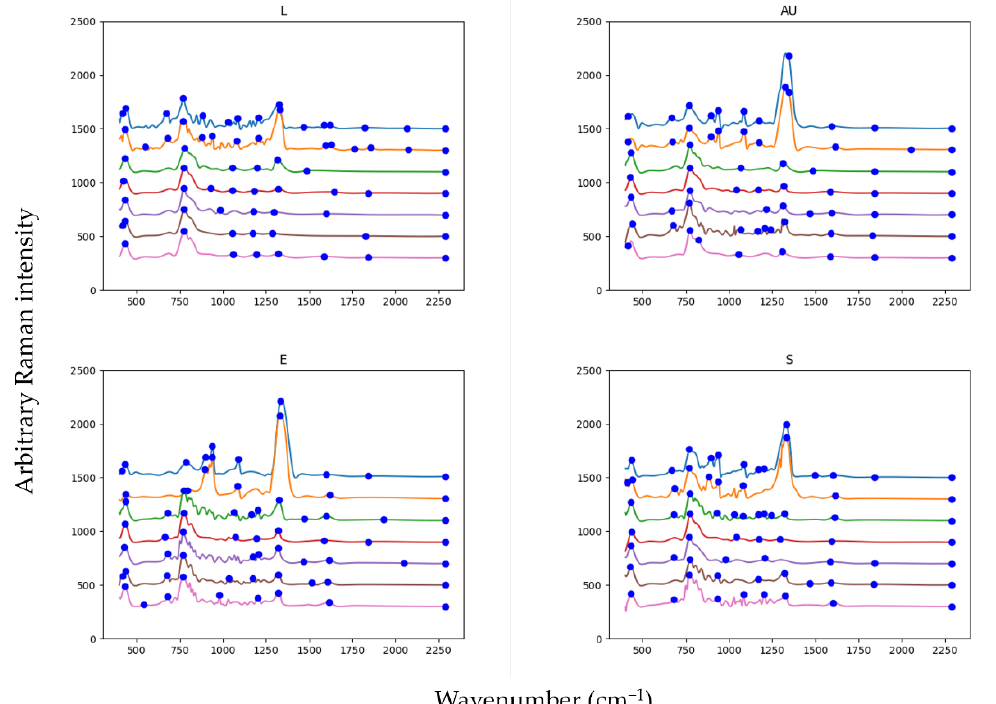
Figure 1. Raman spectra for each monoculture: L. monocytogenes (L), S. aureus (AU), E. coli (E), and S. enterica (S); lines are displayed for better observation and represent the spectra acquired at different time points from top to bottom: 24 (blue), 18 (orange), 8 (green), 6 (red), 4 (purple), 2 (brown), and 0 h